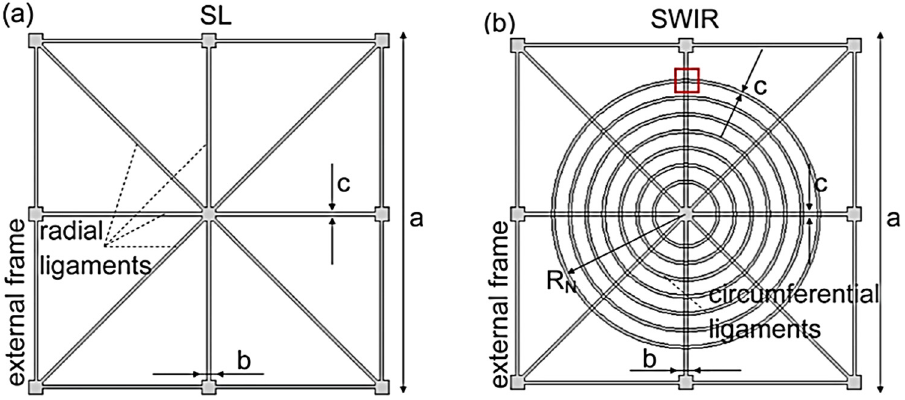
Figure 9: Structural model of a sonic metamaterial ( 88 ) . ( a ) Traction part. ( b ) Hoop direction. Copyright 2016,